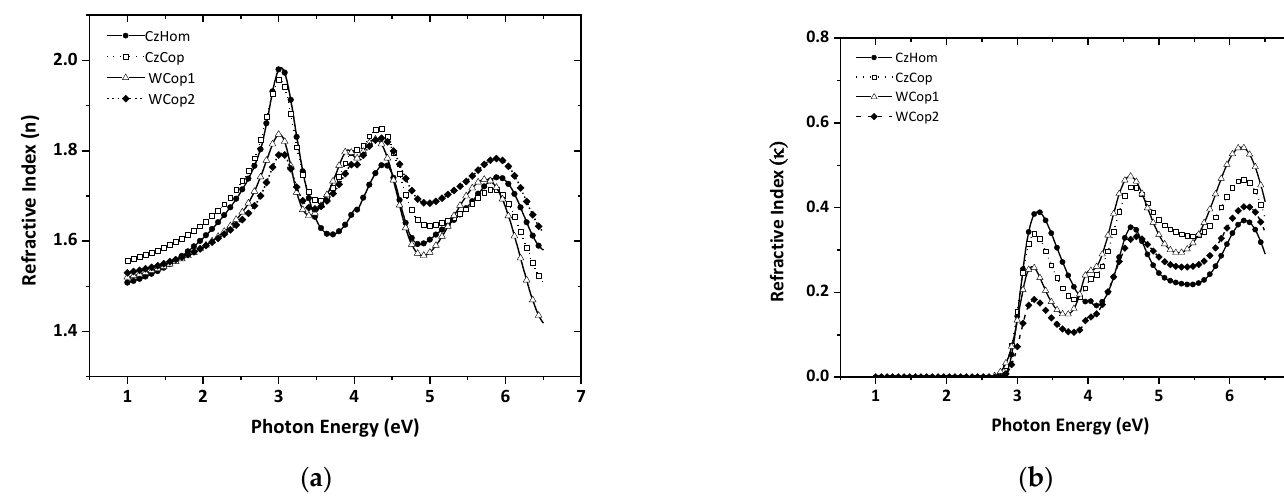
Figure 3. The ( a ) real 𝑛( E ) and ( b ) imaginary 𝜅( E ) part, of the refractive index 𝑛̃(𝐸) of the studied films calculated using the best-fit parameters derived by SE analysis procedure.